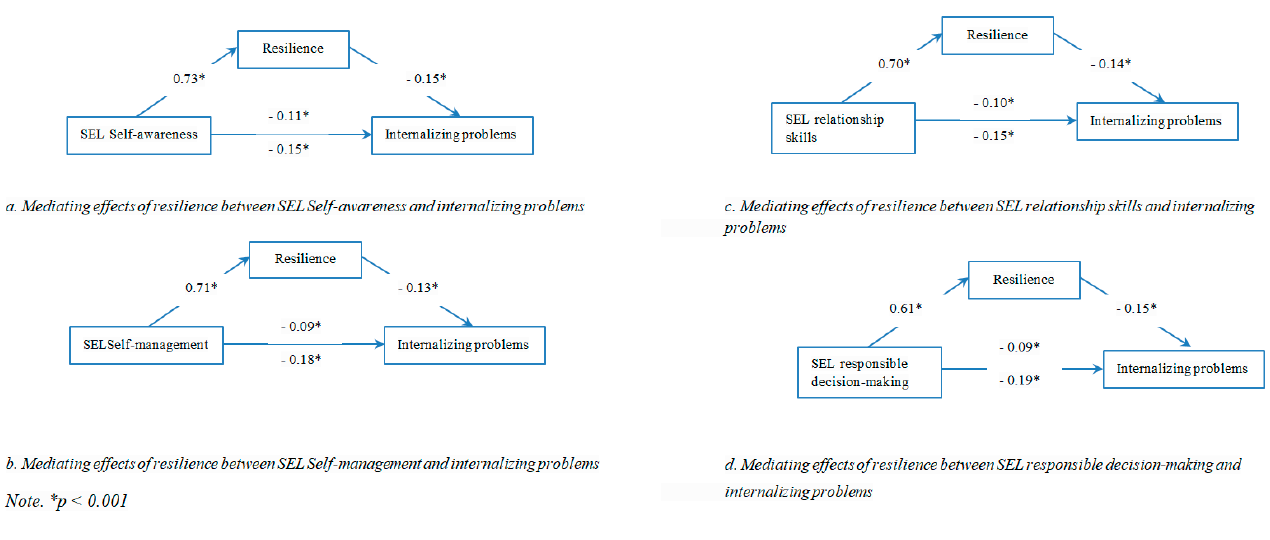
Figure 1. Mediating effects of resilience between SEL dimensions and internalizing problems.